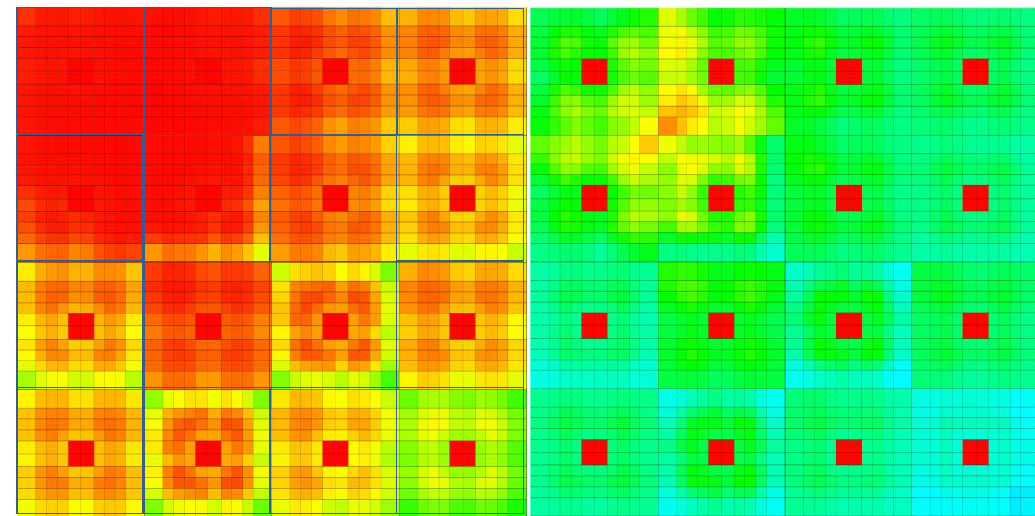
Figure 8. Same as Figure 7, but for the moderator density distribution. (blue: low, green: medium, red: high)